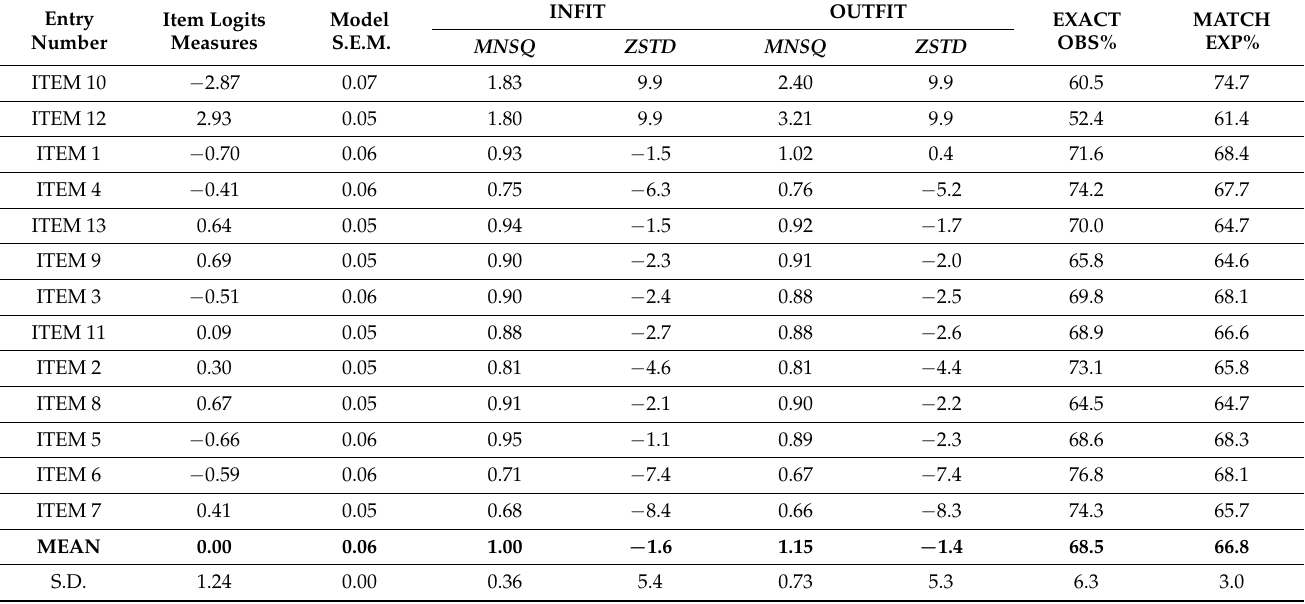
Table 4. INFIT MNSQ and OUTFIT MNSQ